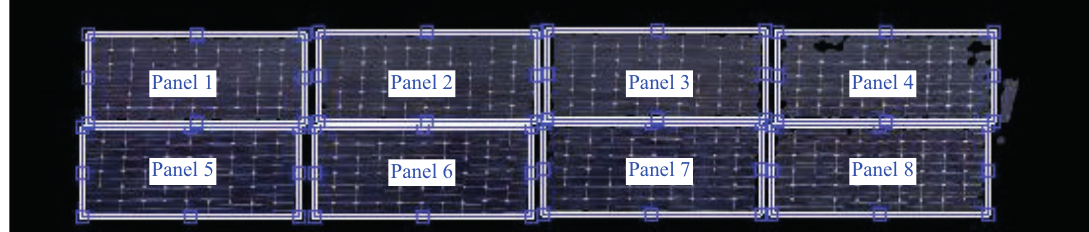
Figure 9. Photovoltaic module detection.